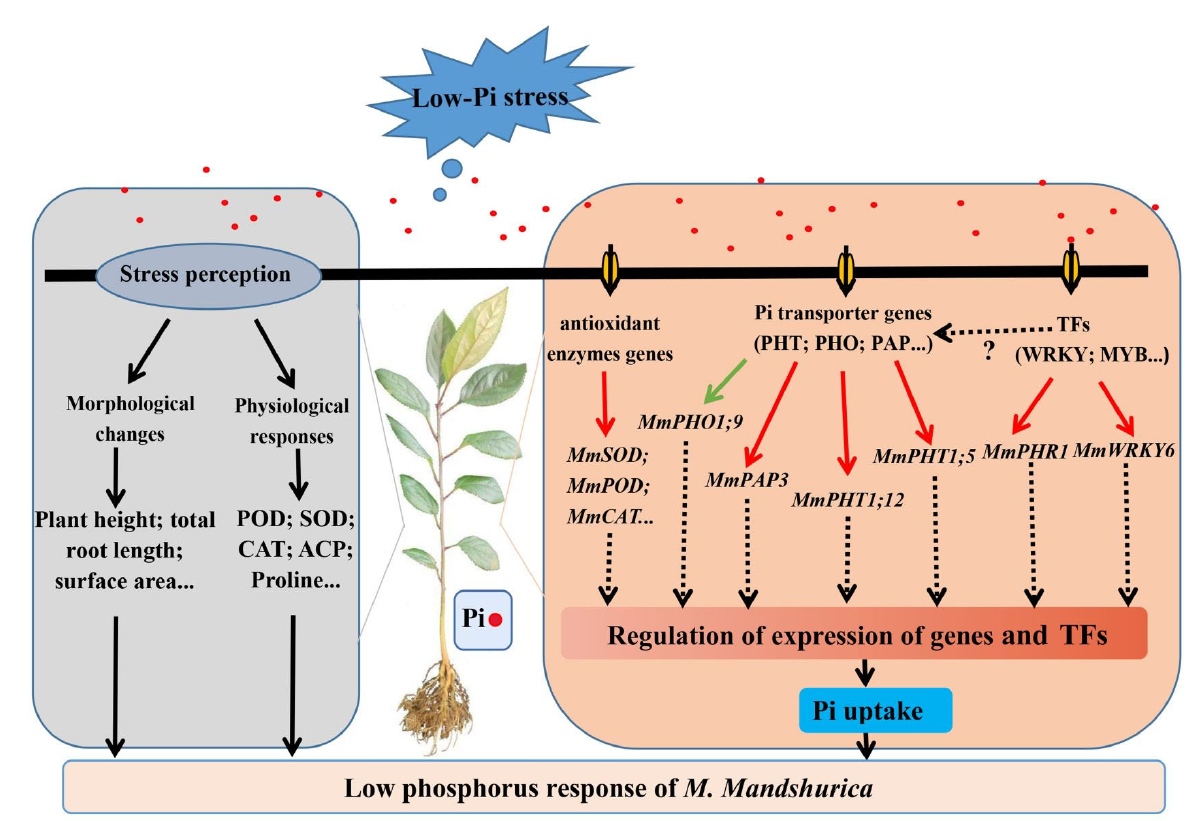
Figure 11. The response model of M. mandshurica to low − Pi stress. The red or green lines represent positive or negative effects, respectively; and the black or black dotted lines represent the progressive relationships or the unknowns, respectively.